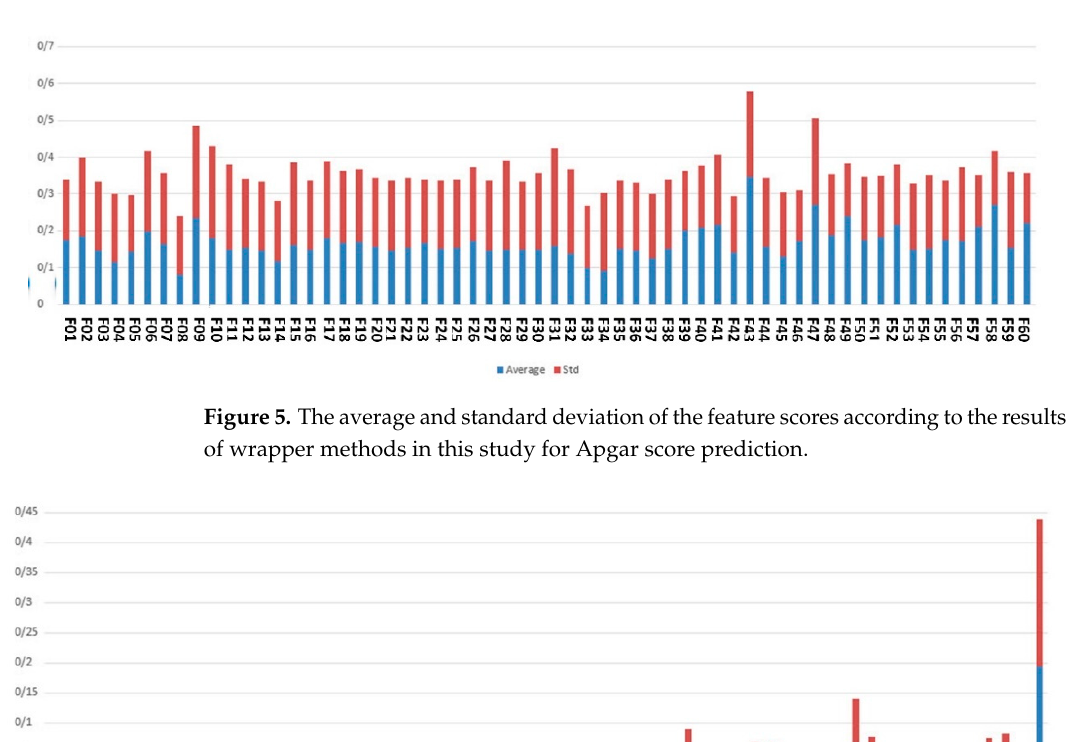
Figure 4. The average of the feature scores obtained by ensemble of filter-based feature scoring method.